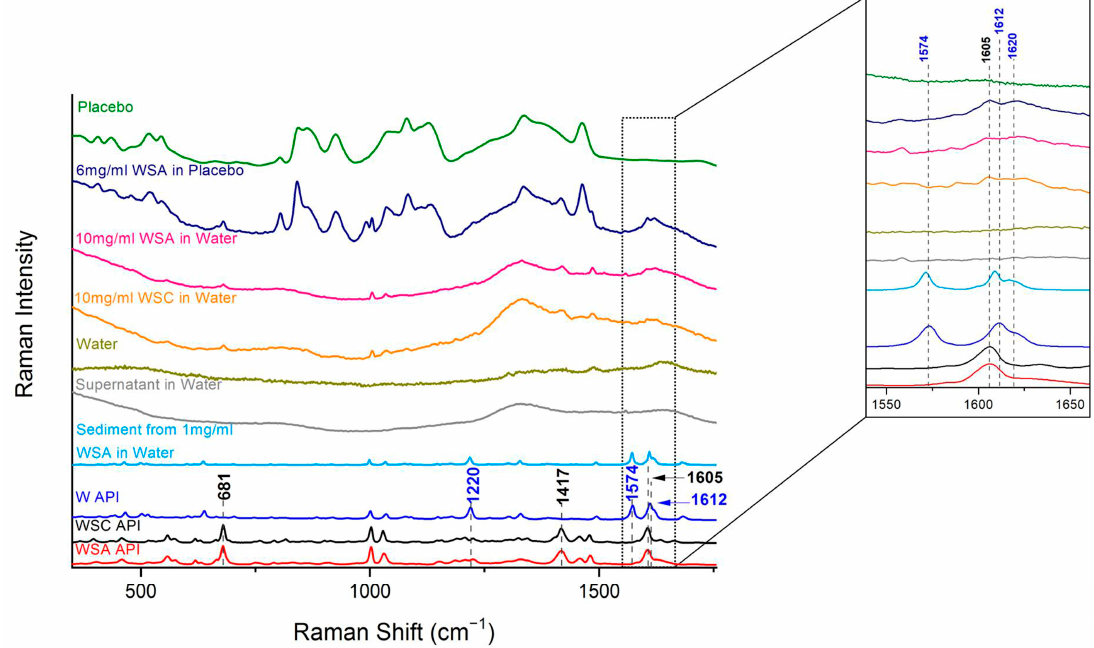
Figure 3. Raman spectra of warfarin placebo, warfarin sodium amorphous (WSA) solution in placebo (6 mg/mL), warfarin sodium amorphous solution in water (10 mg/mL), warfarin sodium clathrate (WSC) solution in water (10 mg/mL), water, supernatant of WSA in water (10 mg/mL), sediment of the suspension of 10 mg/mL WSA in water, warfarin (W) API, warfarin sodium clathrate (WSC) API, and warfarin sodium amorphous (WSA) API. Characteristic peaks of the APIs are indicated. Insert: Magnification of spectral area 1550–1650 cm − 1 .